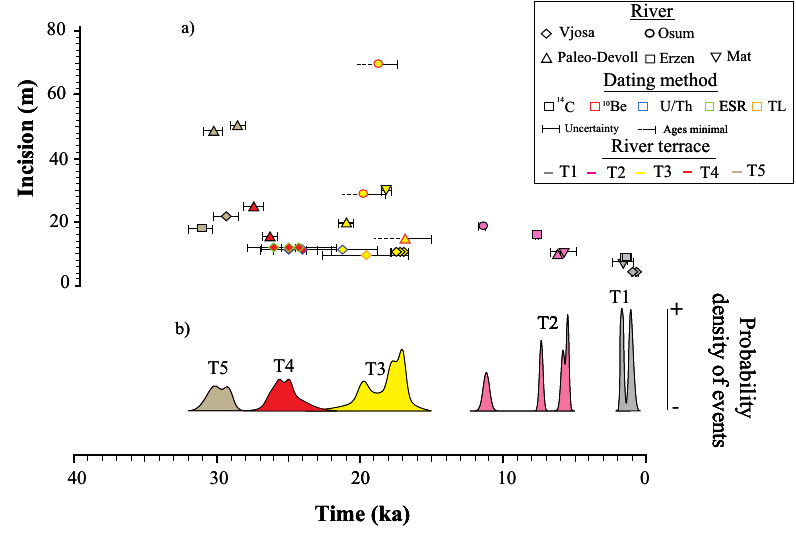
Figure 9. Compilation of Albanian terraces ages for the last 30 ka (Table 1). (a) Plot of incision versus terraces ages. Each terrace is repre- sented by a symbol related to the river. The colour of the border of the symbol corresponds to the dating method while the fill corresponds to the terrace level. (b) Probability density curves of age of terraces. The probability curves was produced by calculating calendar ages and their two sigma (95%) analytical errors and then summing the normal probabilities distribution defined by individual ages using the OxCal program version 4.1 [Ramsey 2009].